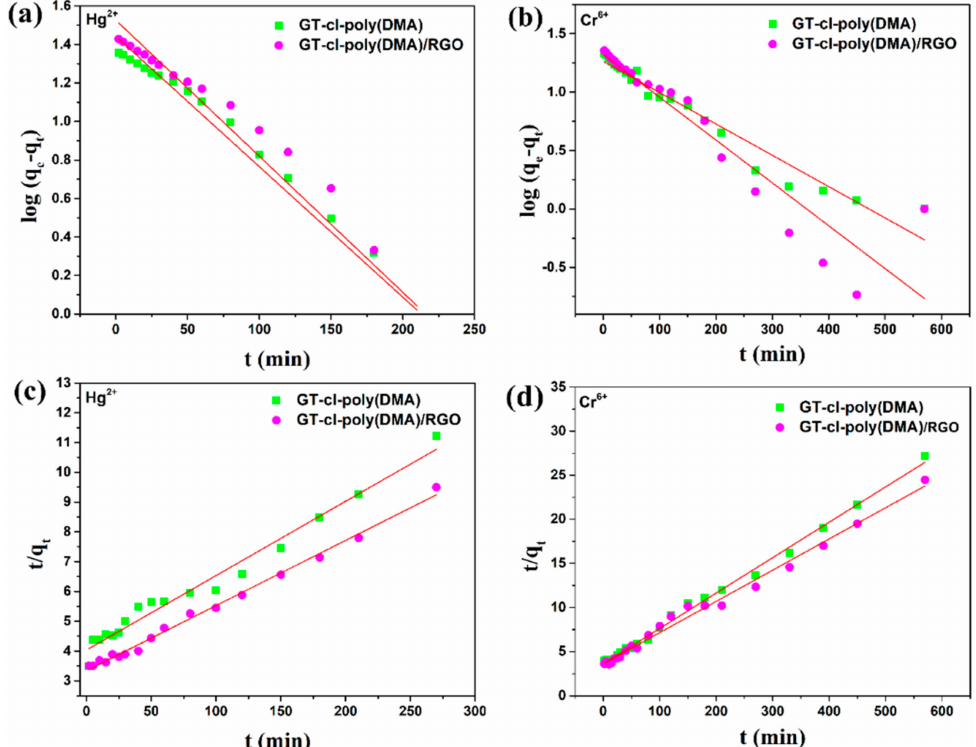
Figure 7. Pseudo first order for ( a ) Hg 2 + and ( b ) Cr 6 + , pseudo second order for ( c ) Hg 2 + and ( d ) Cr 6 + .